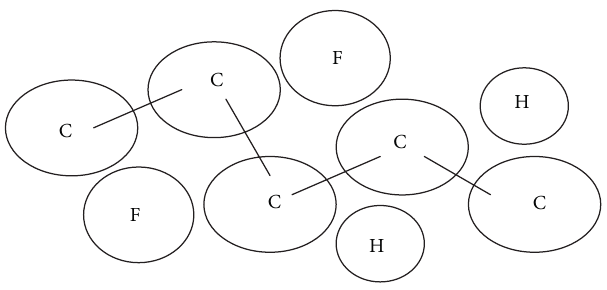
Figure 5: Protective action of fluorine atoms.